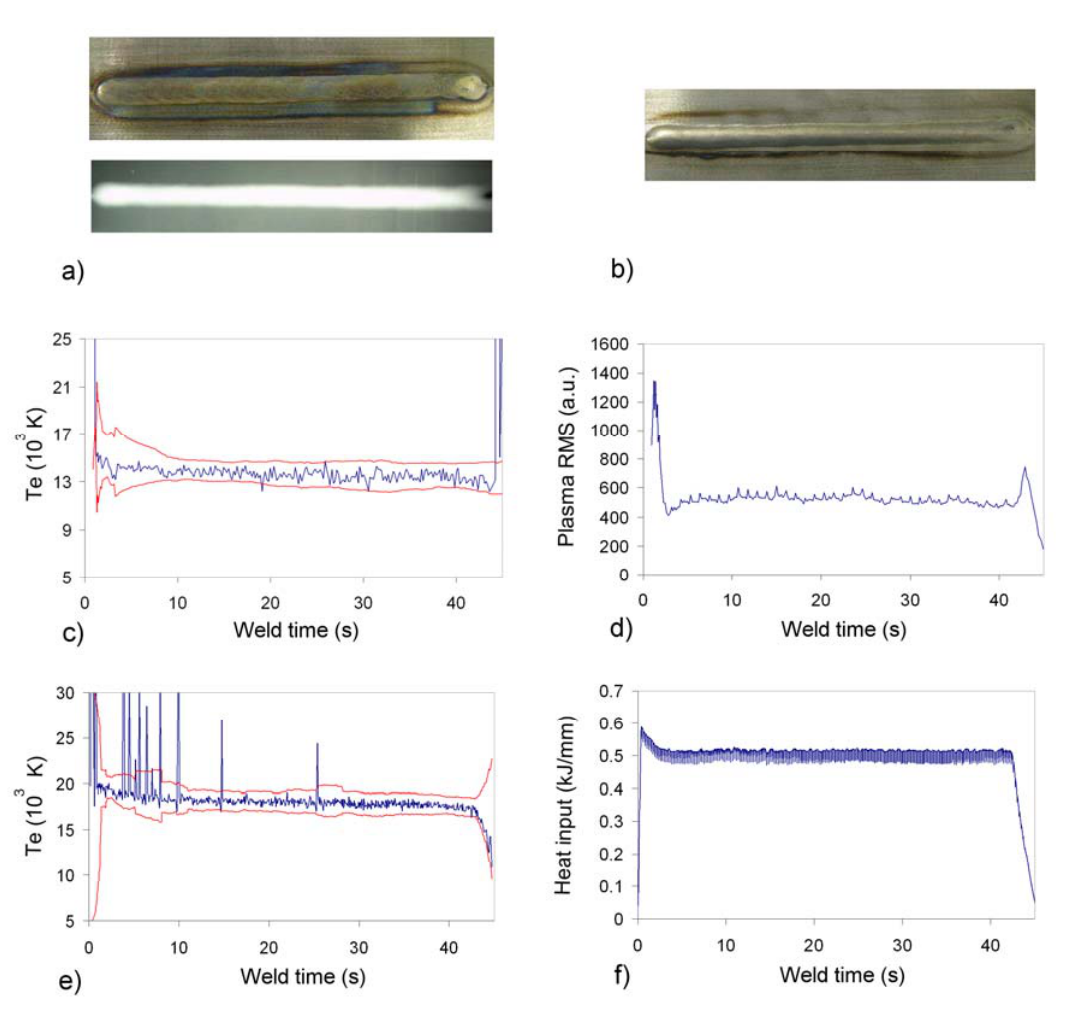
and plasma RMS profiles for defective weld (misaligment) on Figure 5 . Heat input, T e Inconel